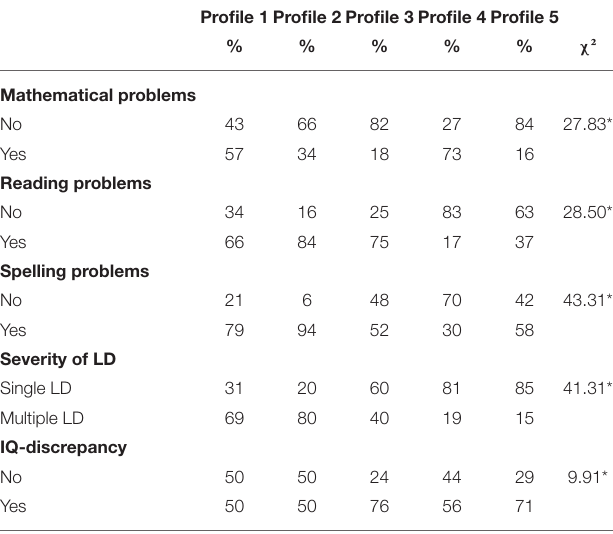
TABLE 6 | Proportional distribution of LD characteristics within the latent